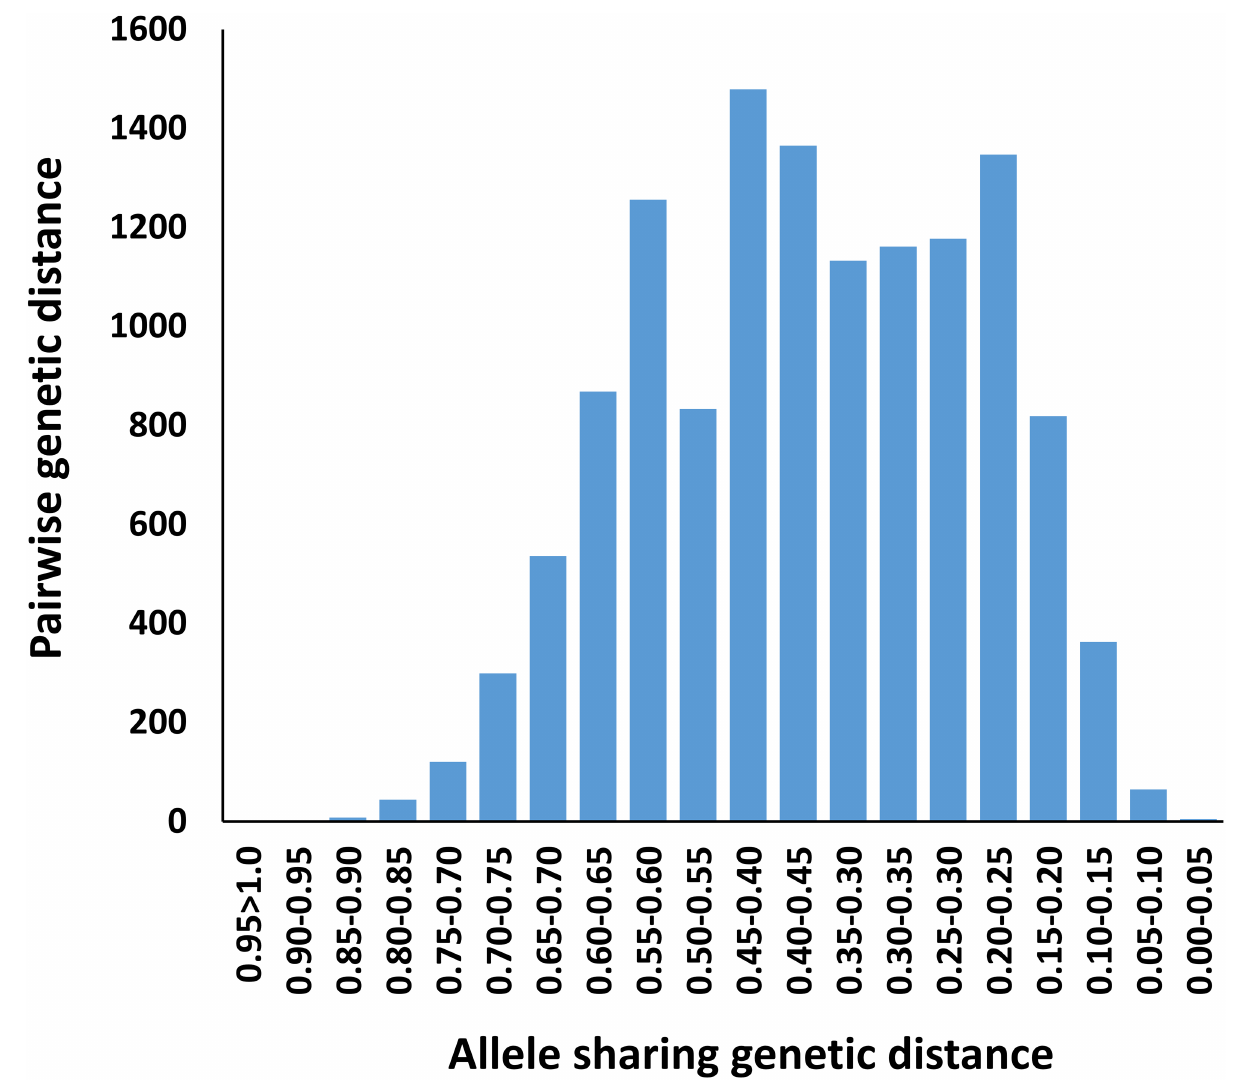
Fig 1. Distribution of allele sharing genetic distance among 158 NPGS Senegal sorghum accessions.